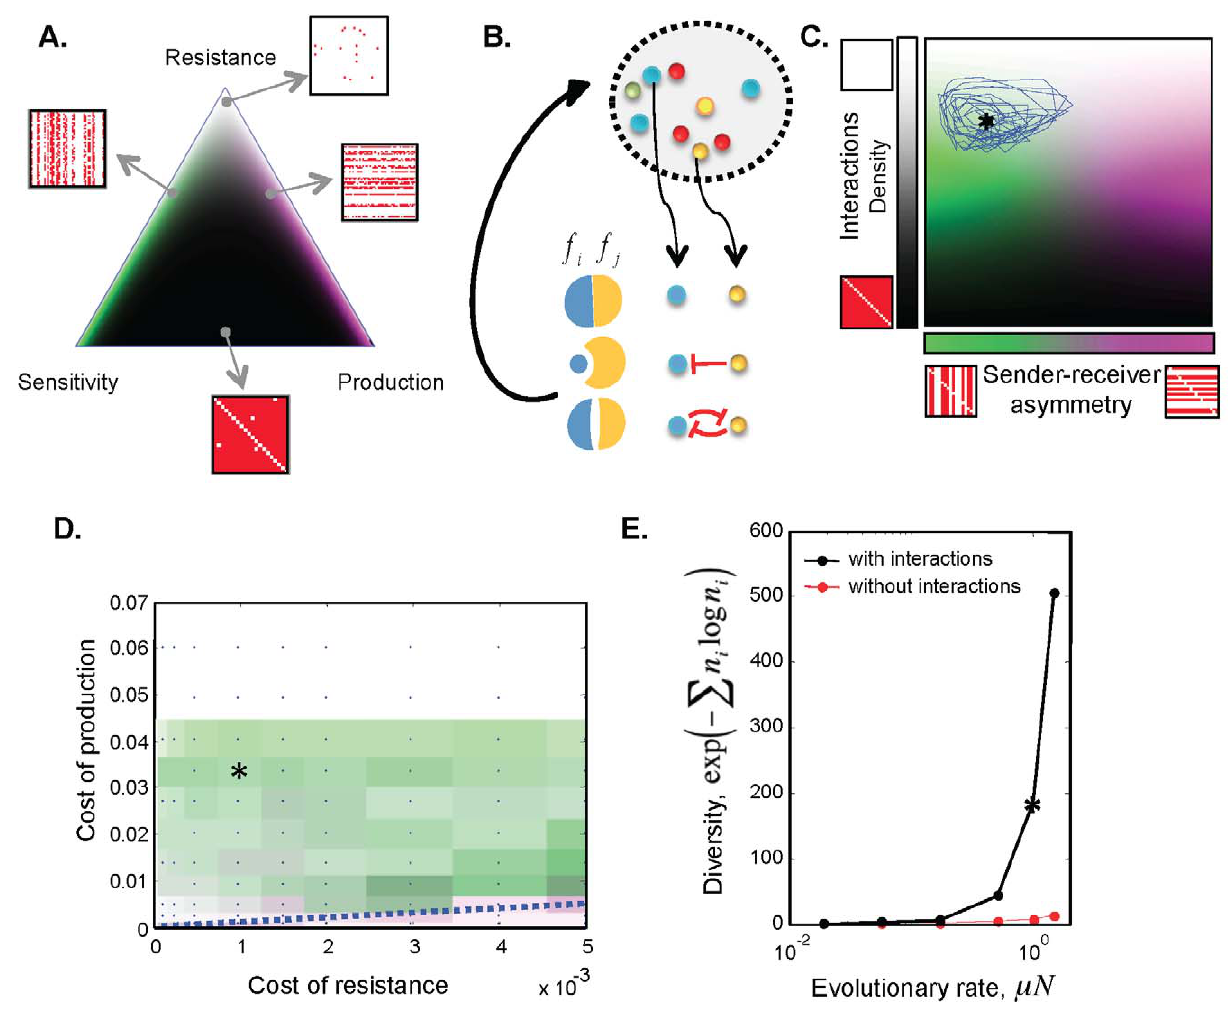
Figure 4. Balanced and moderately sender-determined matrices emerge naturally from an evolutionary model of antibiotic interactions. (A) Matrix statistics for in silico strains randomly assigned production, resistance, or sensitivity to 40 antibiotics. A point inside the triangle specifies the probabilities of producing, being resistant to, or being sensitive to antibiotics. The triangle vertices correspond to the cases where every community member is sensitive to, resistant to, or producer of all antibiotics. Probabilities are proportional to the distance from the opposing edge, and sum to 1. The color represents the fraction of interactions and the sender-receiver asymmetry in the color scheme used in (2C). (B) Schematic of the ecological dynamics. The fitness of a colony (e.g. number of spores it produces) is determined by the pairwise interactions with its neighbors. In the ecological dynamics we average over all possible combinations of neighbors. (C) An evolutionary trajectory, after statistical steady state has been reached, projected onto the plane of interaction density ( y -axis) versus sender-receiver asymmetry ( x -axis). The trajectory fluctuates around a mean value (denoted by *). (D) This mean value is calculated on a grid of costs of production and resistance (blue dots; patch color represents the mean interaction density and sender-receiver asymmetry, as defined in C). In a large area of parameter space, when production cost is larger than resistant cost (above the blue dotted line), the interaction matrix is balanced and sender determined (green shades). Very low resistant cost would lead to low density of interactions (not shown). (E) Functional diversity requires both ecological interactions and evolution. Functional diversity is shown as a function of evolutionary rate for simulations with species interactions (black circles) and with effect of interactions on the dynamics disabled (red dots). Two organisms are considered functionally distinct if they interact differently (as senders or receivers) with an existing organism. Diversity is expressed as the exponential of the Shannon-Wiener Index, and the population evolutionary rate is m N (plotted for fixed population size N =10 6 and varied mutation rate m ). The stars in (C), (D), and (E) correspond to the same simulation, the dynamical properties of which are shown in Figure S4.